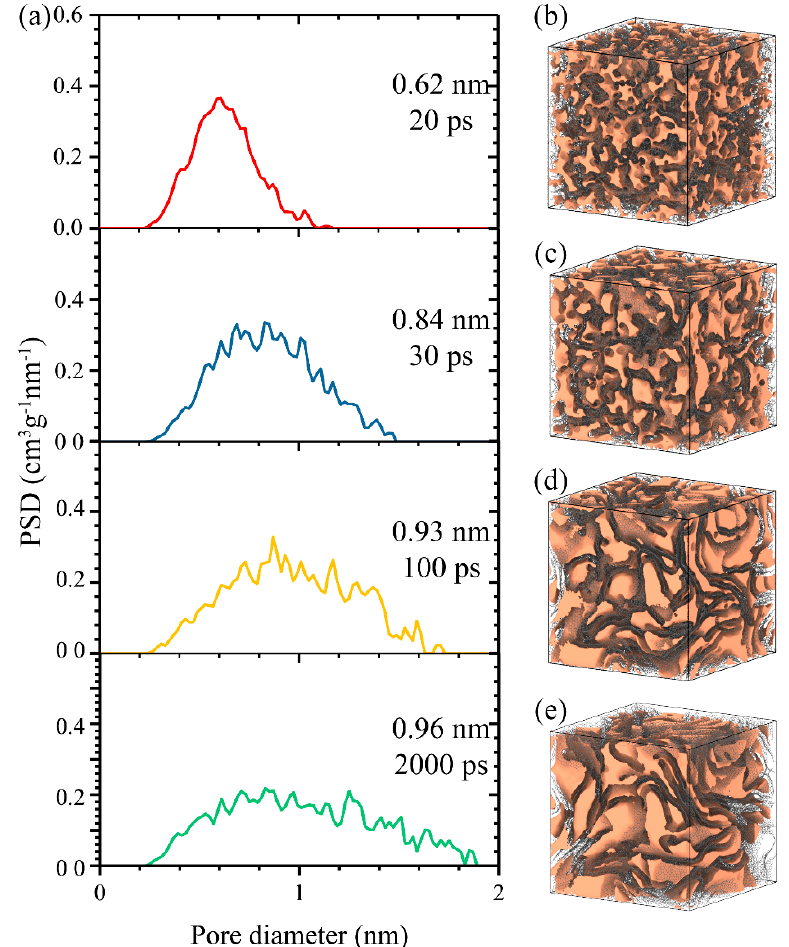
Figure 2. ( a ) Pore size distribution function at several annealing time shown in different panels. The average size of pores is shown in the corresponding panel. ( b – e ) The open pore structure at each time was rendered and displayed on the